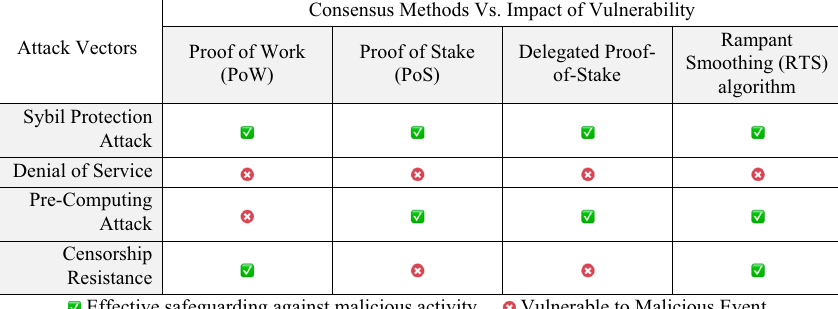
Table 5 Adversary tolerance comparison between exiting schemes (PoW, PoS, and Deligated PoS) and proposed